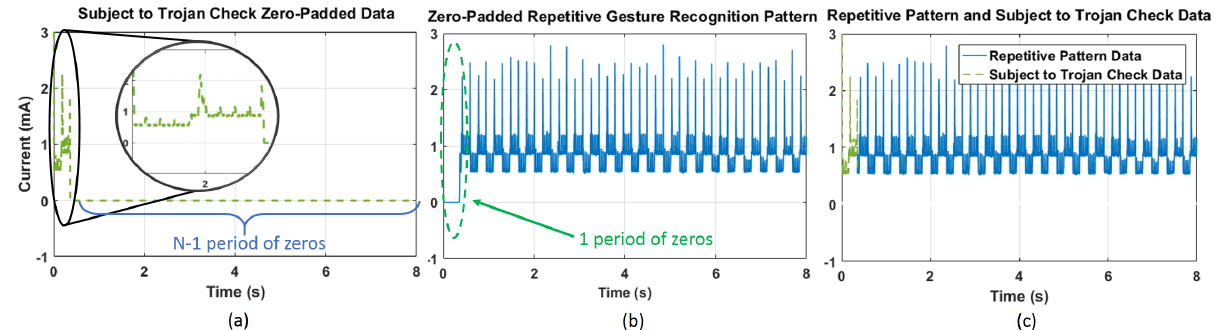
Figure 2. ( a ) Zero padded data that is subjected to Trojan check; ( b ) zero-padded repetitive gesture recognition pattern with one period of zero padding at the starting; ( c ) stitched one period of data to repetitive gesture recognition